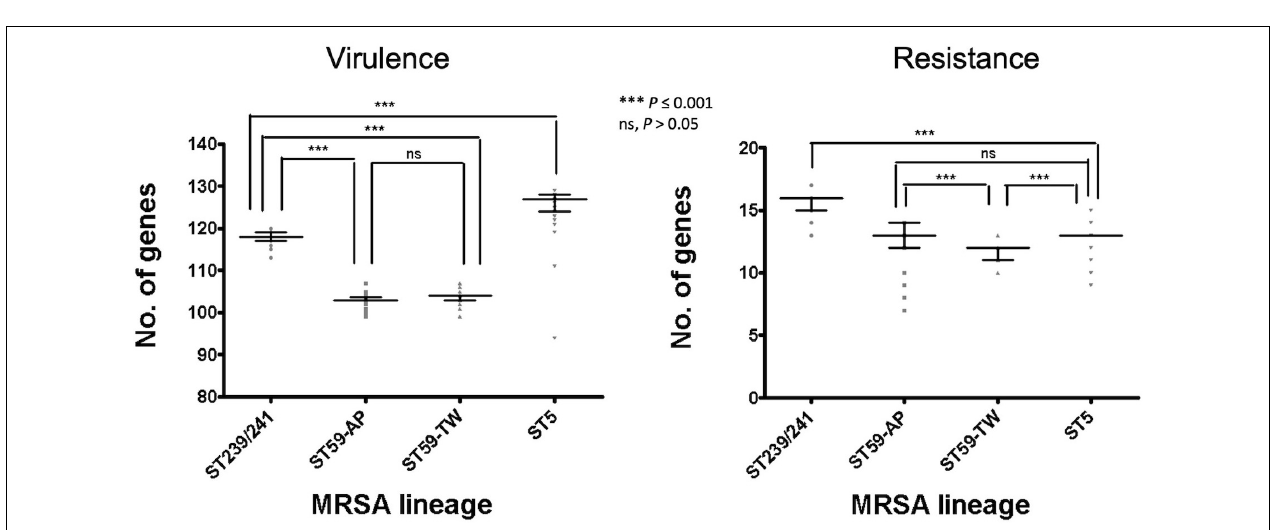
FIGURE 5 | Distribution of genes mediating the antimicrobial resistance in methicillin-resistant Staphylococcus aureus isolates of three prevalent lineages, ST239/241, ST59, and ST5, in Taiwan.